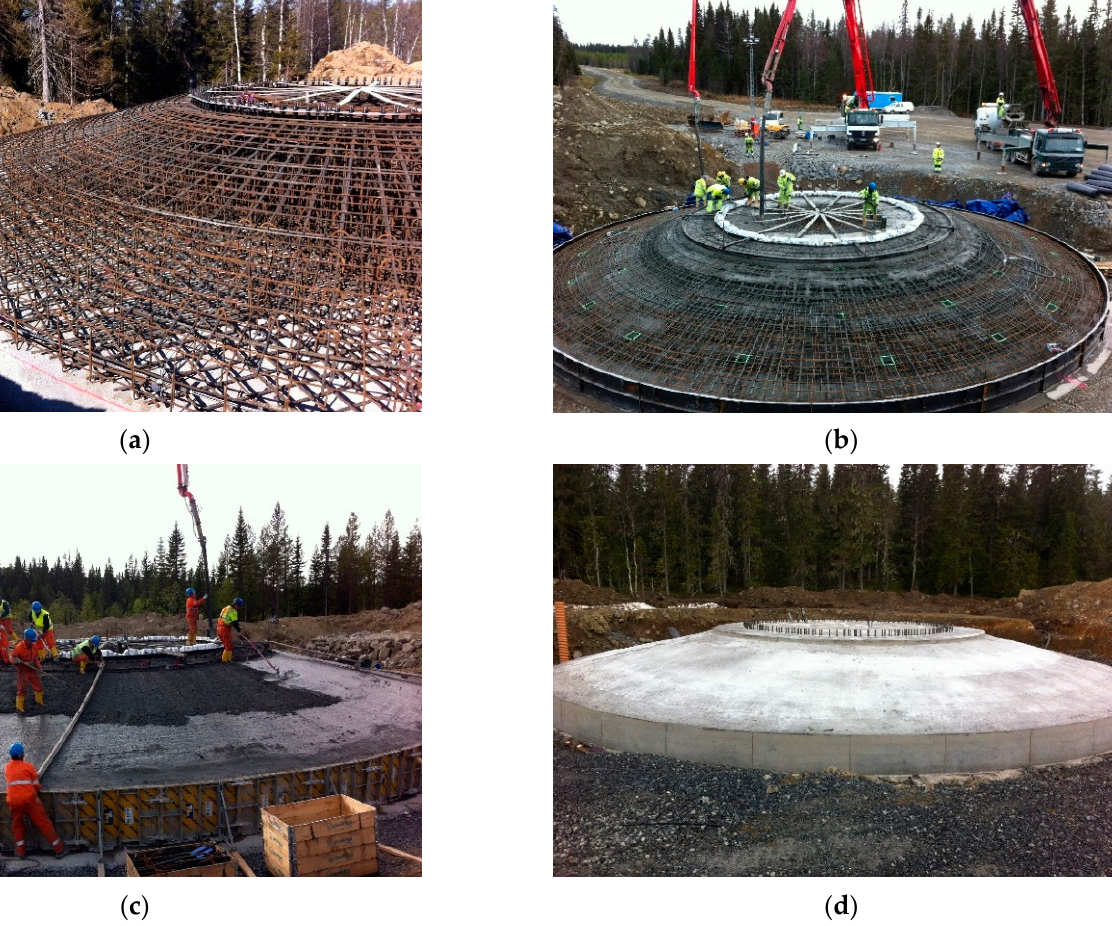
Figure 3. Photos of the construction of the foundations, ( a ) after placing the reinforcement, ( b , c ) during casting of the concrete, and ( d ) the completed foundation before backfilling with soil.